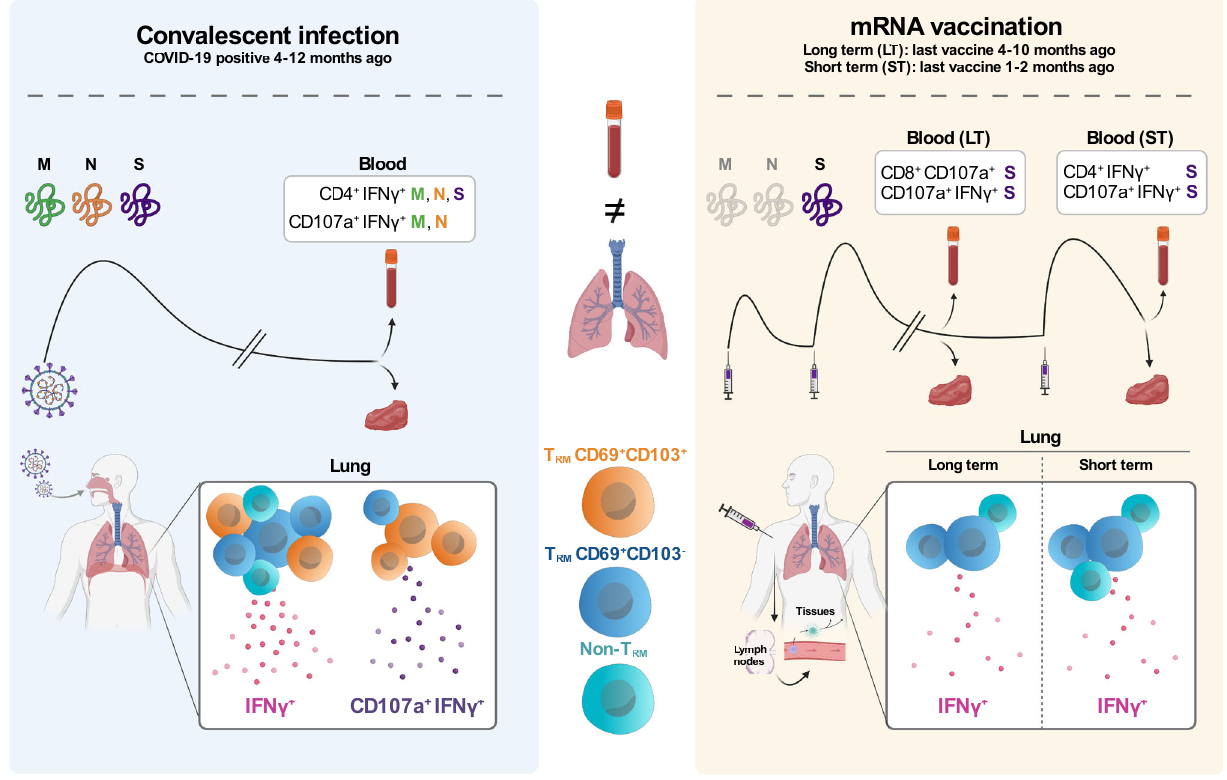
Fig. 7 | Graphical summary of the main fi ndings in this study. The focus of the studywastoidentifyT cellresponsesagainst SARS-CoV-2inpaired blood and lung tissue samples of patients that recovered from COVID-19 between 4 to 12 months ago (convalescent infection, left panel) and patients that were uninfected and mRNAvaccinatedeitherbetween4to10monthsago(LTlongterm,rightpanel)or between1and2monthsago(STshortterm,rightpanel).Left:InfectionwithSARS- CoV-2 triggers the immune system to respond against multiple viral proteins, including the M, N, and S proteins. In the blood of convalescent patients, CD4 + T cells responded to M, N, and S peptides by producing IFN γ and both CD4 + and CD8 + T cells responding to M and N peptides by producing IFN γ and CD107a. Moreover, in the lung of these patients, we found T cells with mainly T